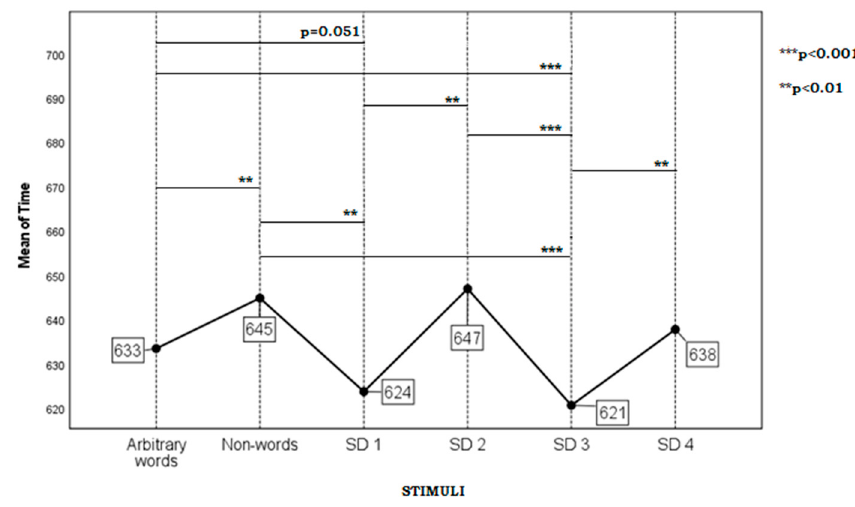
Figure 3. Word recognition time (in ms) depending on the type of the stimuli in Russian.